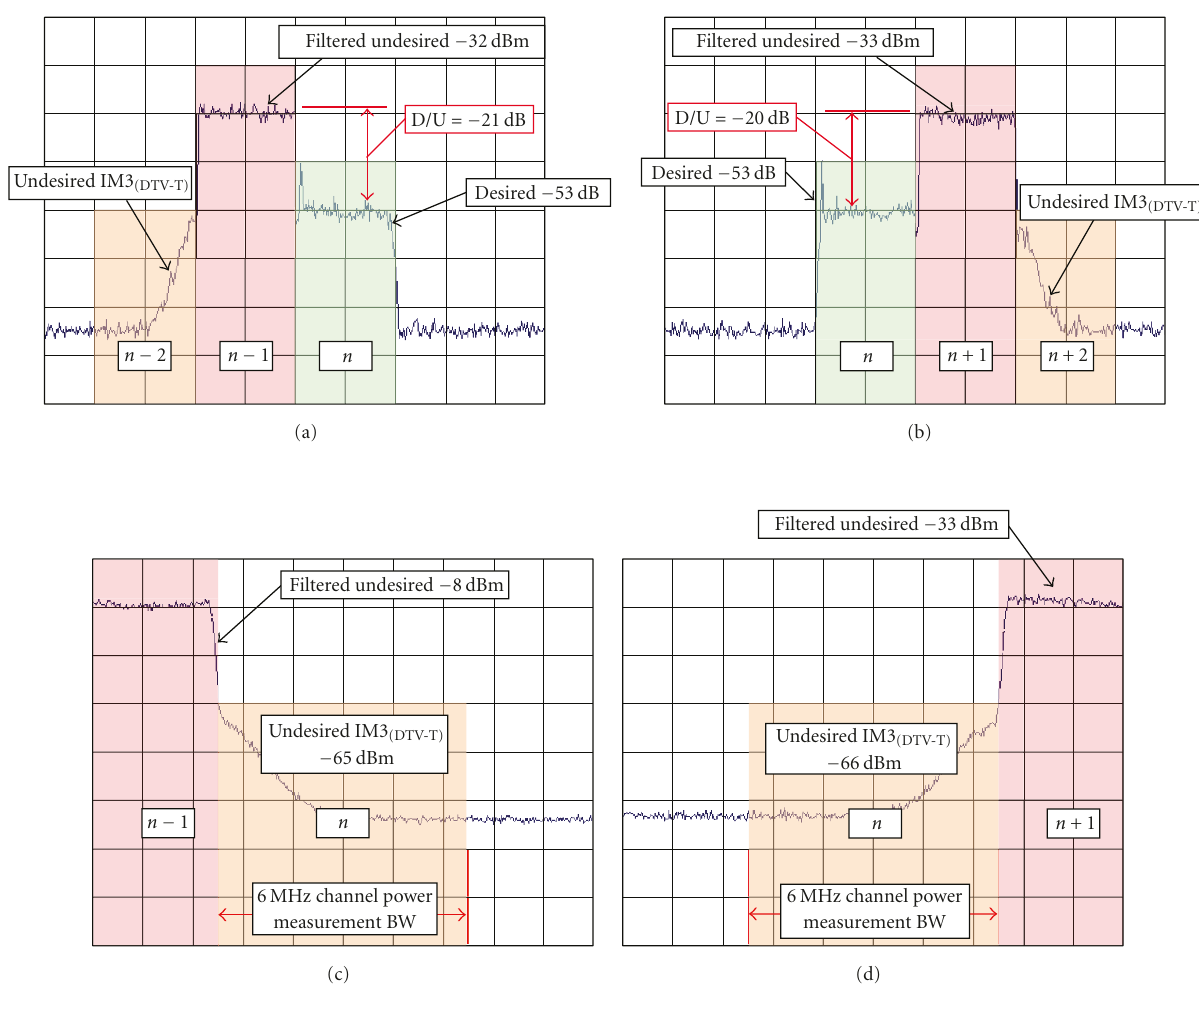
Figure 9: (a) n = − 53 dBm; undesired signal at n − 1; significant IM 3(DTV-T) configuration (b) n = − 53 dBm; undesired signal at n + 1; significant configuration (c) IM 3(DTV-T) level present in desired channel n . undesired signal at n − 1; significant IM 3(DTV-T) configuration. (d) IM 3(DTV-T) level present in desired channel n . Undesired signal at n + 1; significant IM 3(DTV-T) configuration.